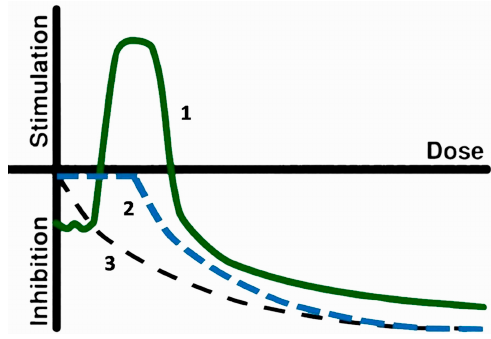
Figure 1. Scheme of dose–effect models: 1, hormesis; 2, threshold; 3, linear.